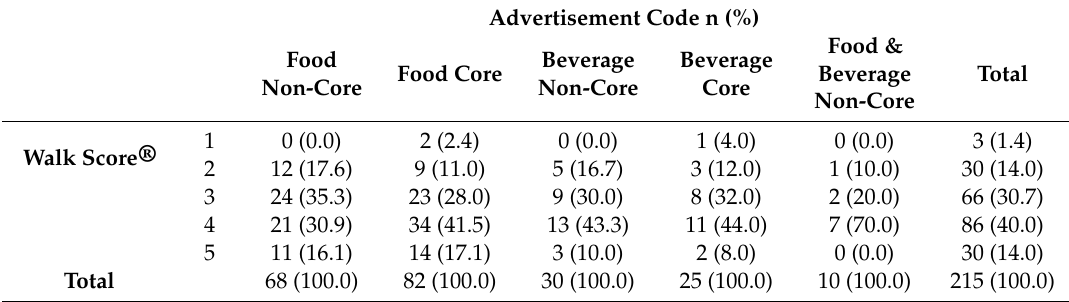
Table 5. Proportion of Food and Beverage Advertisements by Walk Score